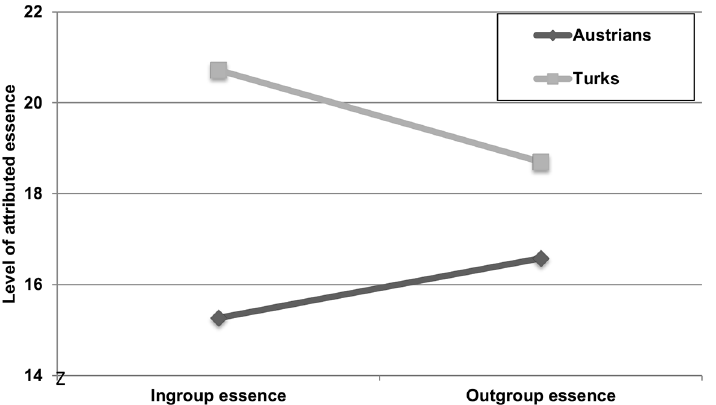
Figure 1. Interaction between ethnic group (Austrians vs. Turks) and ethnic target essence attribution (ingroup vs.